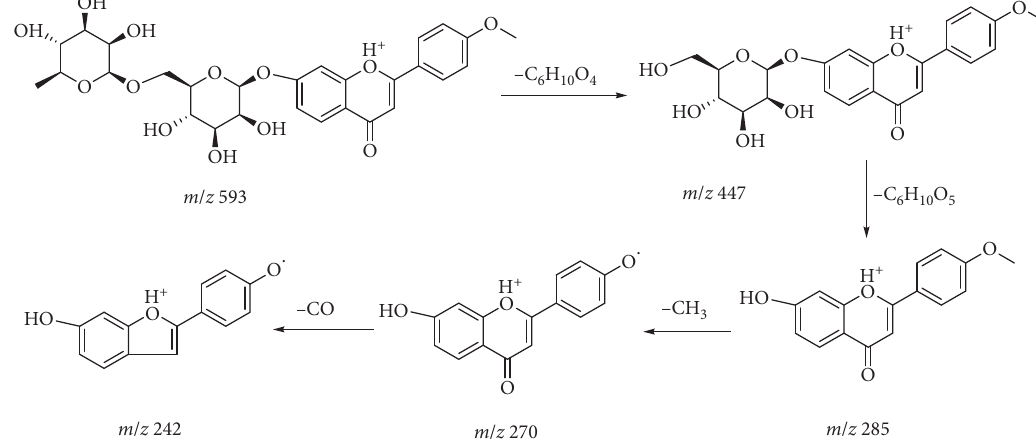
Figure 2: Possible MS fragmentation pathway of linarin.